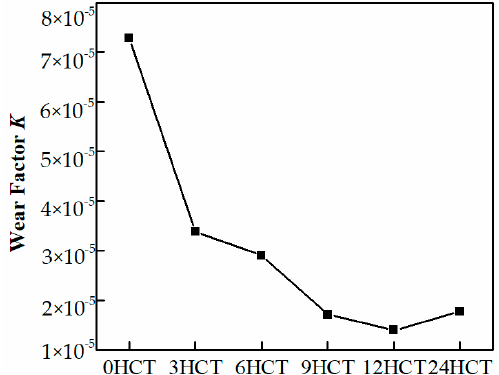
Figure 8. Wear factor of cladding coatings.